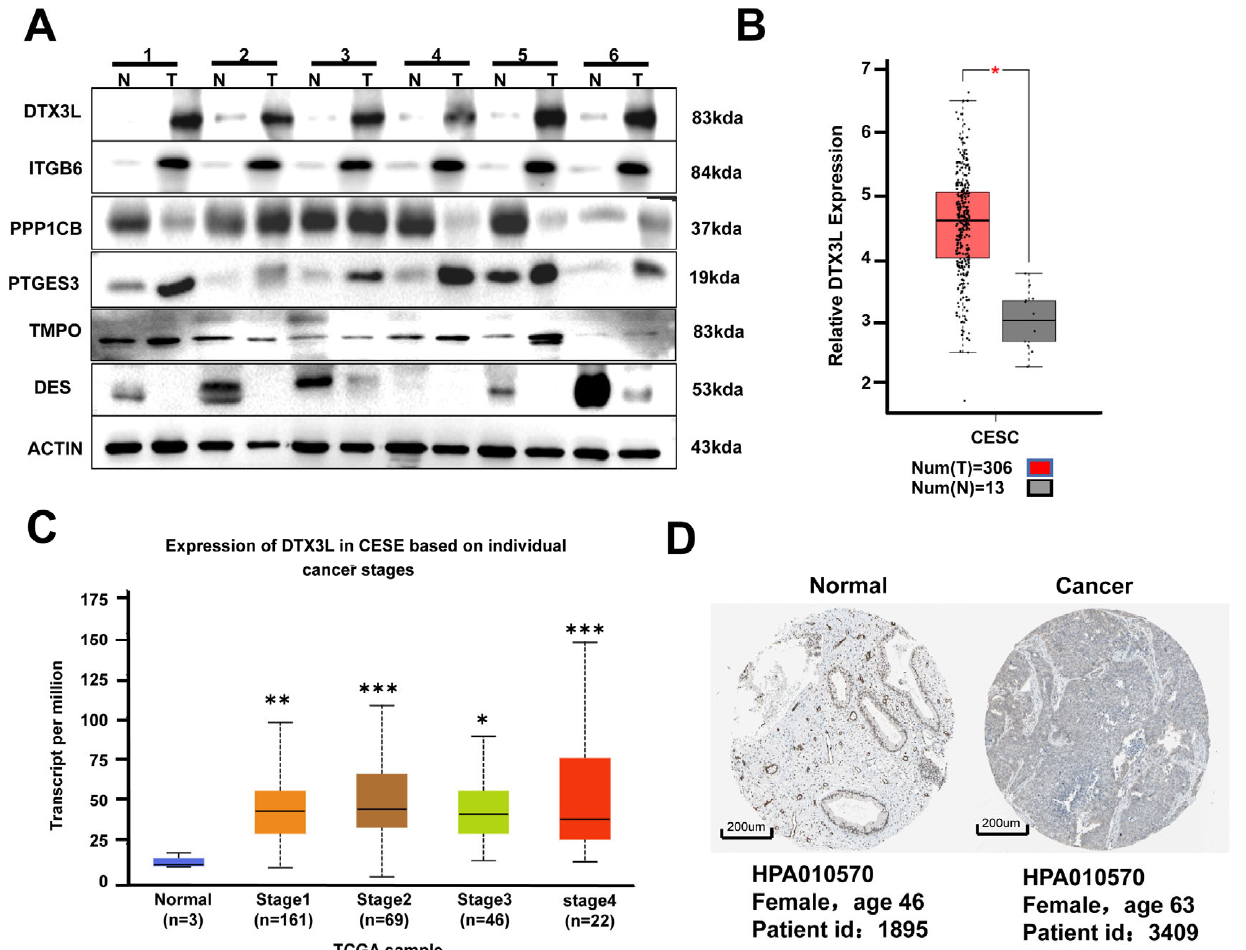
Figure 2. DTX3L was upregulated in CC tissues. ( A ) The expression of six selected proteins in CC and adjacent normal tissues was examined by using Western blot analysis. ( B , C ) The expression of DTX3L in CC and normal tissue was analyzed based on the TCGA dataset (Normal vs. Stages, * p < 0.05, ** p < 0.01, *** p < 0.001). ( D ) Representative immunohistochemistry images showing the expression of DTX3L in CC tumor tissues and normal tissues based on the THPA database.